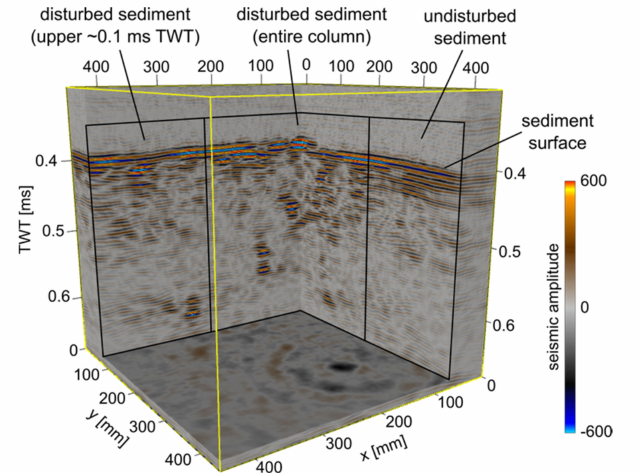
Figure 3. Seismic volume shows the reflections of varying manual disturbances in the soft sediment. Undisturbed sediment ( right ) is characterized by continuous high-amplitude reflectors at the surface and a transparent appearance below. The reflectors of the sediment surface of disturbed parts ( middle and left ) show interruptions and variations in amplitude strength. Reflections of disturbed sediment below appear discontinuous, with limits partly sharp, partly fading into transparency with varying strength of amplitude. This pattern ceases below 0.5 ms TWT where only the upper sediment layer was disturbed. To some extent, random reflector fragments appear due to the object exchange from previous experiments.